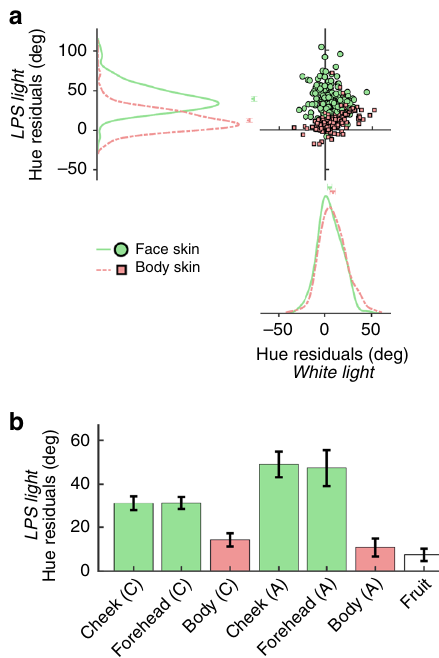
Fig. 4 The impact of stimulus category on hue matches under low-pressure sodium light is greater for face skin than body skin or fruit. Hue matches to face skin (cheek, forehead), body skin (neck, hand), and fruit (tomato, strawberry, orange) were estimated from the multivariate linear regression model (see Fig. 3; ( N = 20 participants). a Hue angle not explained by the model (residuals) for skin matches under LPS light versus white light (160 face-skin matches, 160 body-skin matches: 2 face-skin regions; 2 body-skin regions; 4 actors; 20 participants). Markers show averages and 99% C.I. b Residuals for hue matches under LPS light for fruit, and for face skin (cheek, forehead) and body skin (neck and hand, combined) of the two races tested (Caucasian, C; African American, A). Error bars show 99% C.I. Source data are provided as a Source Data fi le